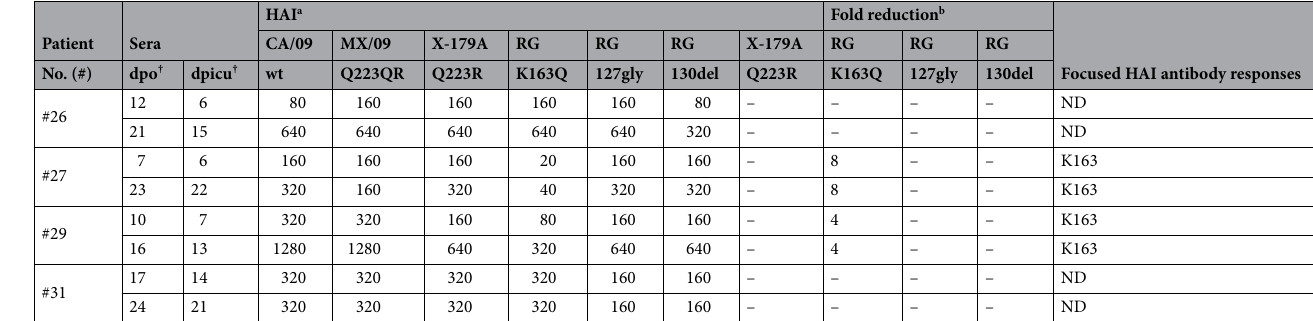
Table 3. CA/09-like virus-infection induced focused HAI antibody responses. † dpo, days post-symptom onset; † dpicu, days post ICU admission; ‡ –, ≤ twofold reductions; ¥ ND, not detected. *Fatal patients in bold. For each sample, we completed three independent HAI assays. a Sera from 26 patients possessing HAI titers of ≥ 80 against wt-CA/09 were tested by HAI assays with the 6 viruses. b Fold reduction of HAI titers against virus- mutant(s) compared to wt-CA/09.